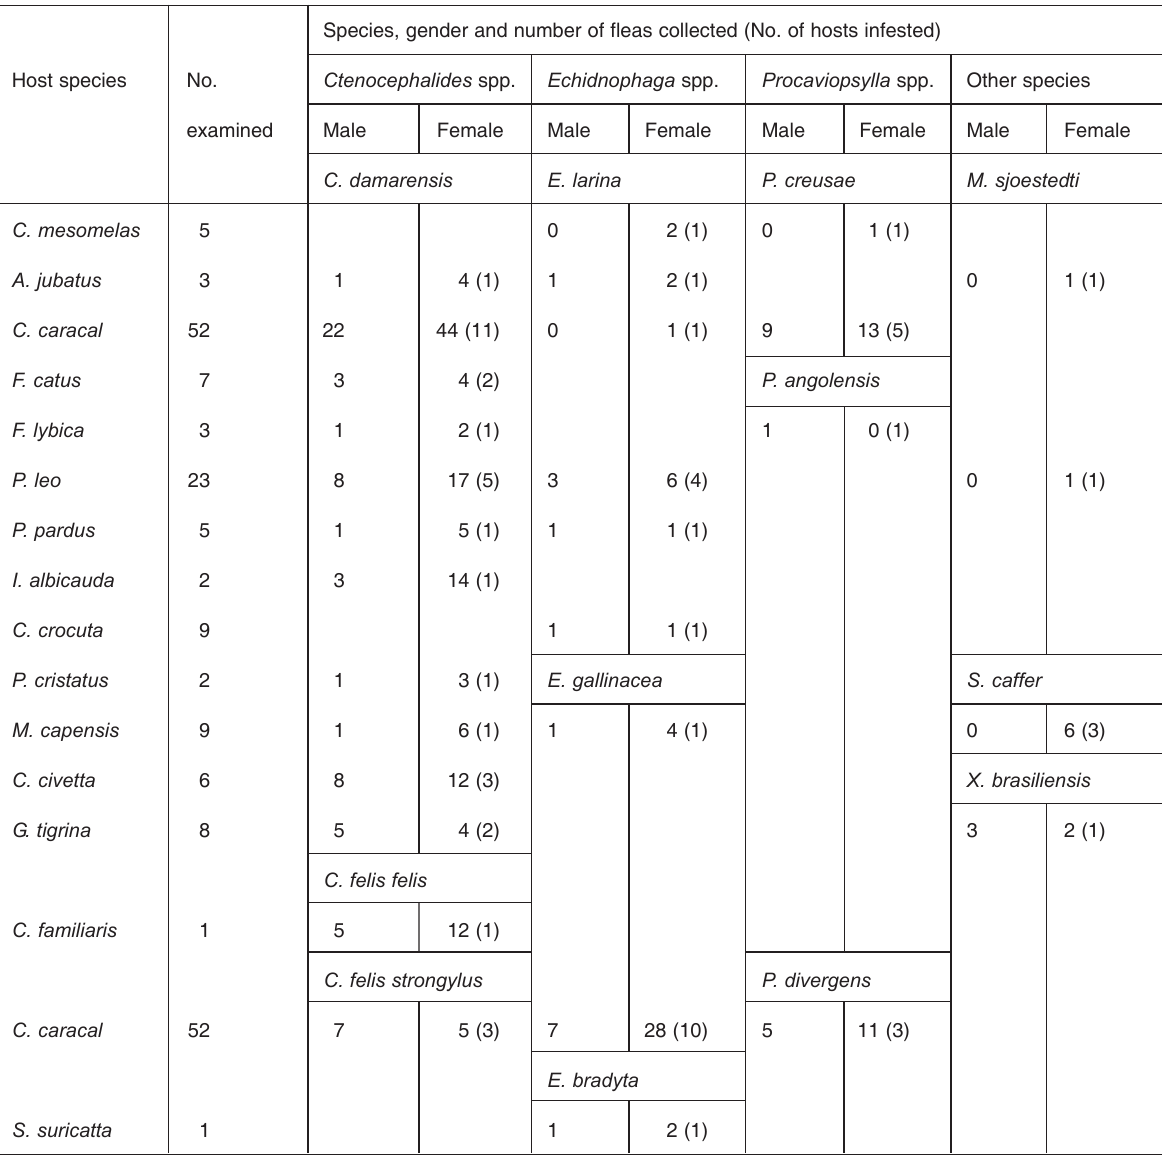
TABLE 2 Fleas collected from wild carnivores, feral domestic cats and a domestic dog in South Africa Species, gender and number of fleas collected (No. of hosts infested) Host species No. Ctenocephalides